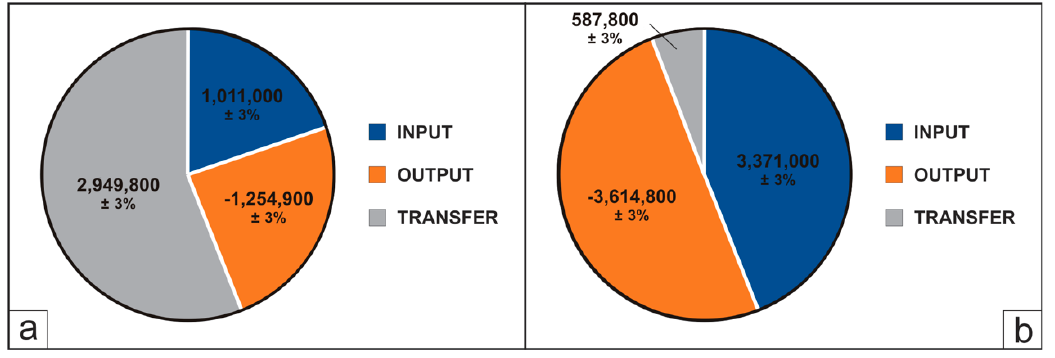
Figure 8. The plots show the contributions of input, output and transfer (expressed in m 3 ) to the anthropogenic sediment budget in the 1980–2020 timespan. ( a ) sediment redistribution activities within the limit of the study area are considered as transfers; ( b ) sediment transfers between different sub-cells are considered as inputs and outputs.